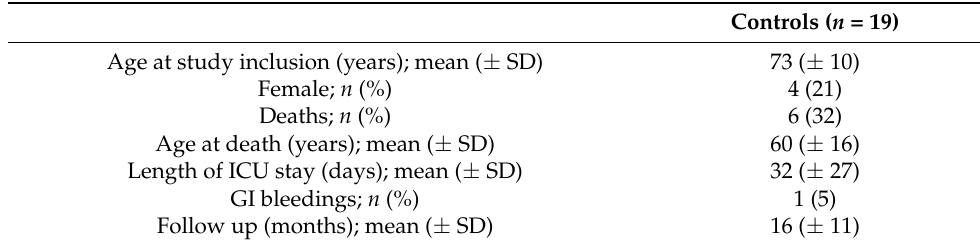
Table 2. Baseline characteristics of patients included in the control group. All patients were treated in the intensive care unit because of cardiac